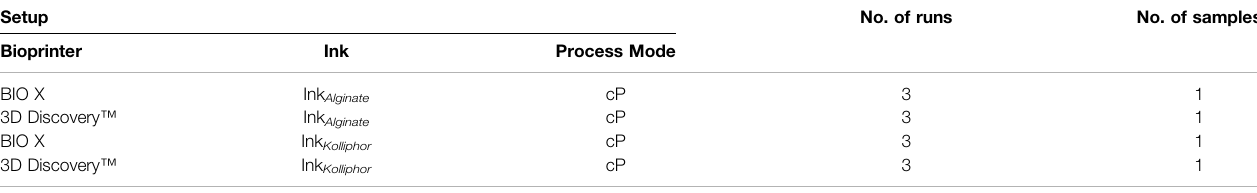
TABLE3| Summaryofallsetupsfortheinvestigationofcartridge fi llinglevelin fl uence.Ink Alginate isanabbreviationforalltestedalginateconcentrationsof8,10,12,and15% (w/v) and Ink Kolliphor for all tested Kolliphor concentrations of 15, 20, 25, 28, and 30% (w/v). Process mode means either constant pressure (cP) or constant fl ow rate (cFR).